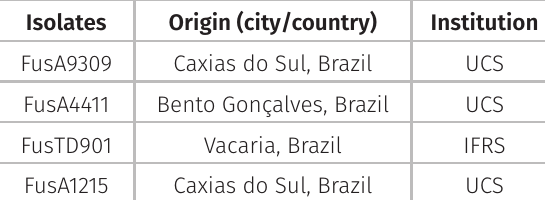
Table I. Isolates of Fusarium sp. used in the in vitro assays.